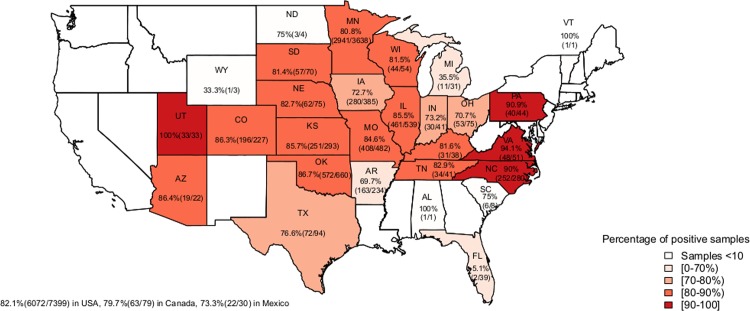
Percentages of any RV positive samples by state.The shading represents variation in percentage of positive samples.